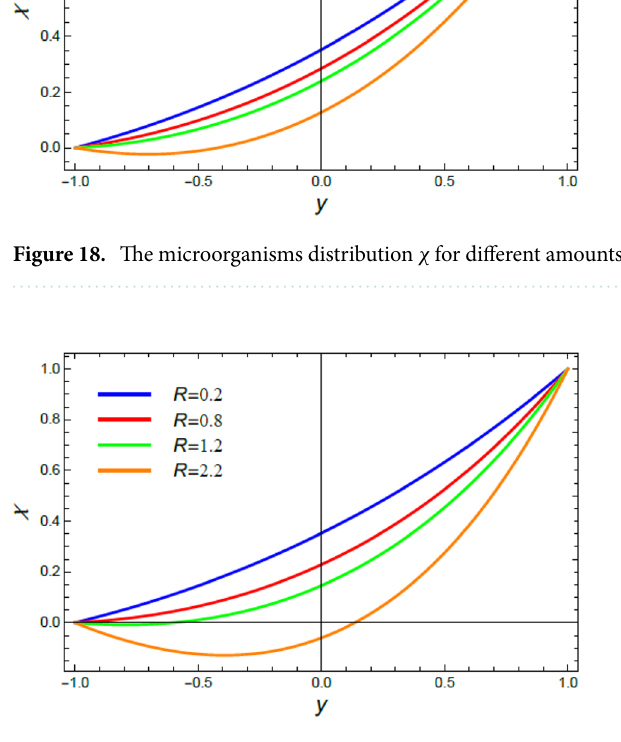
Figure 19. The microorganisms distribution χ for various amounts of the chemical reaction coefficient R .